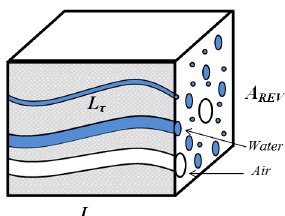
Figure 1. Conceptual model of a porous medium as a bundle of capillaries following a fractal distribution. At a given capillary pressure, the capillary is either filled by water or by air depending on its